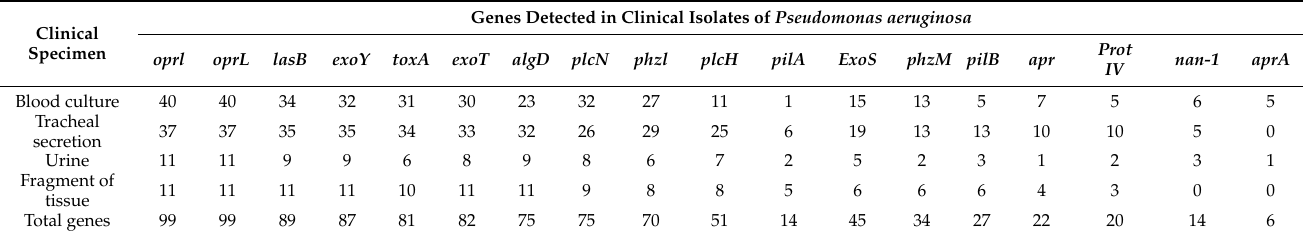
Table 6. Distribution of virulence genes detected in Pseudomonas aeruginosa isolates according to the type of clinical specimen. Genes Detected in Clinical Isolates of Pseudomonas aeruginosa Clinical Specimen oprl oprL lasB exoY toxA exoT algD plcN Blood